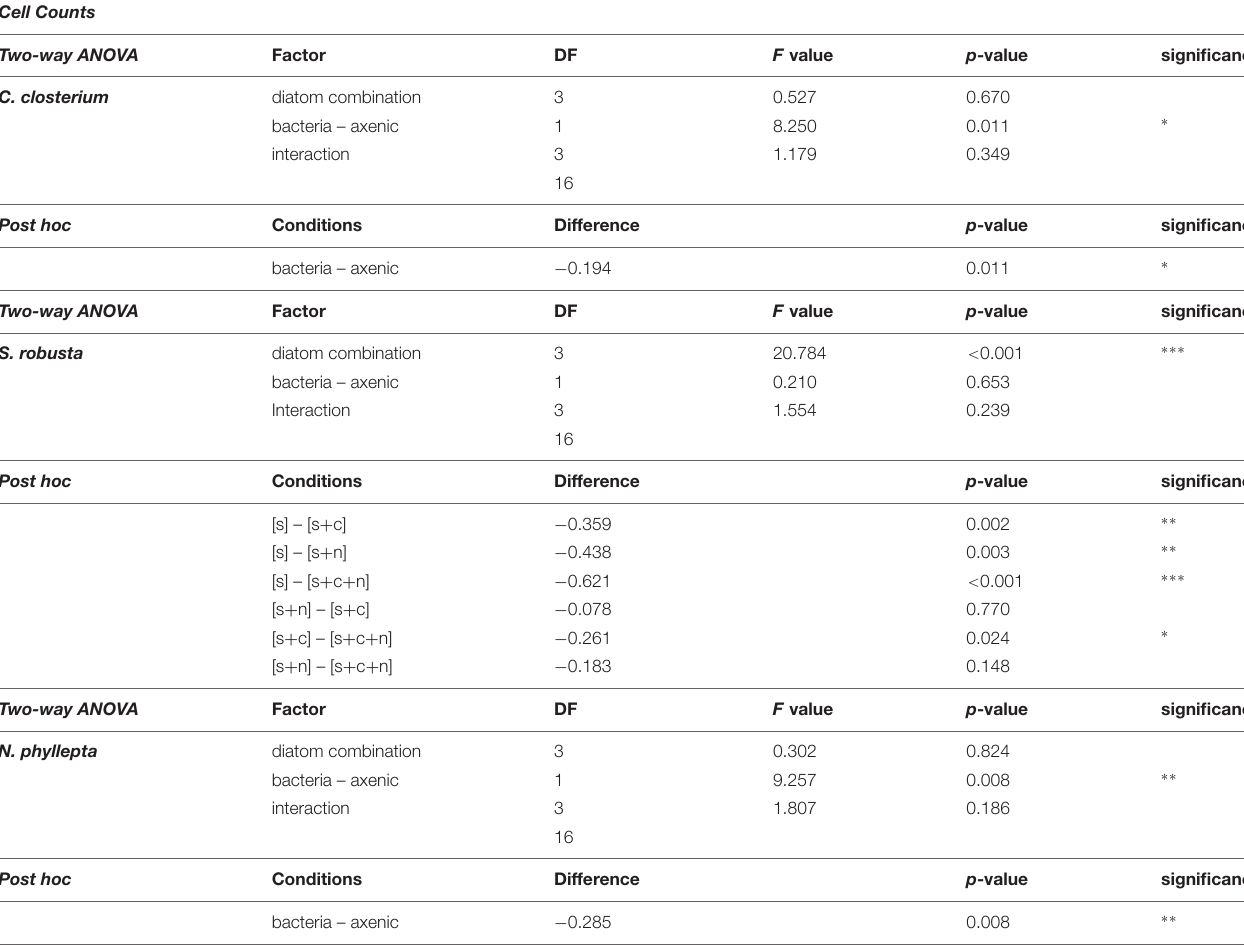
TABLE 1 | Statistical analysis of the maximum growth rates derived from individual cell counts for S. robusta [S], C. closterium [C], and N. phyllepta